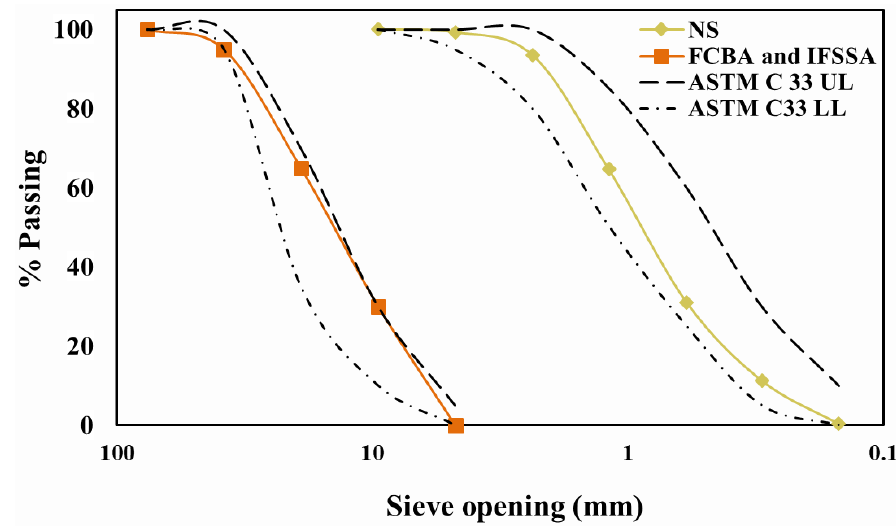
Figure 2. Grain size distribution of FCBA, IFSSA, and NS are plotted with the recommendation provided by the ASTM C33 standard [32].